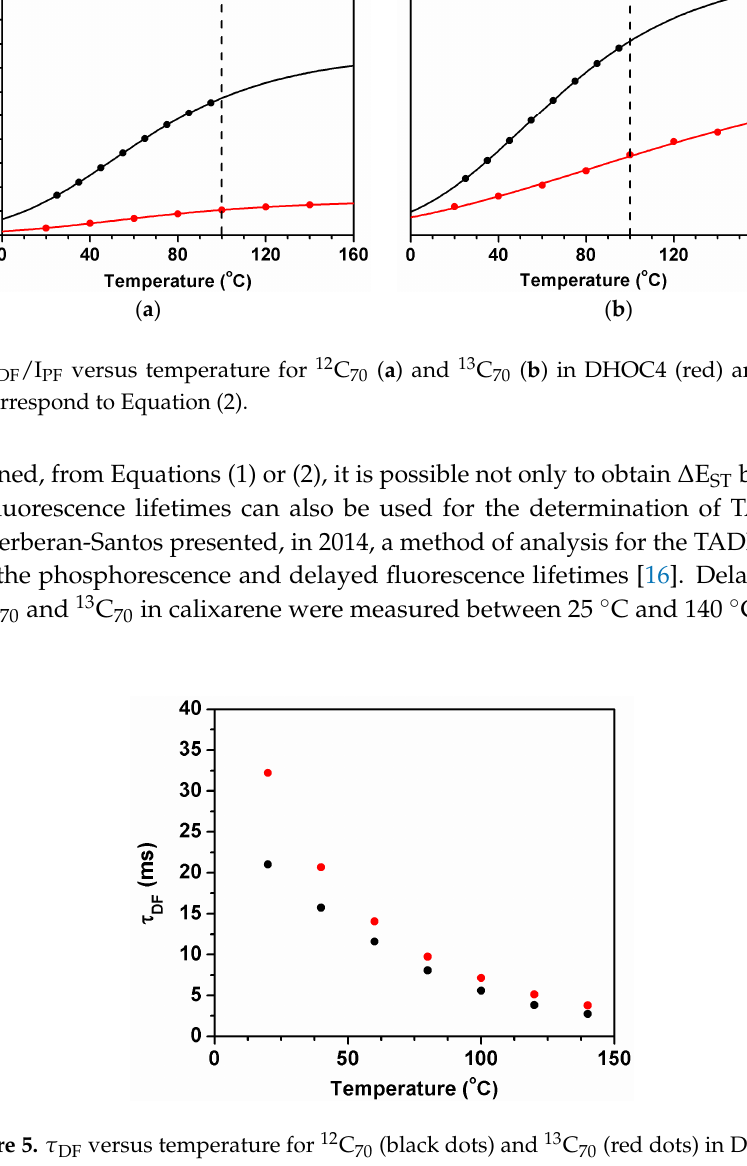
12 C 70 (black dots) and